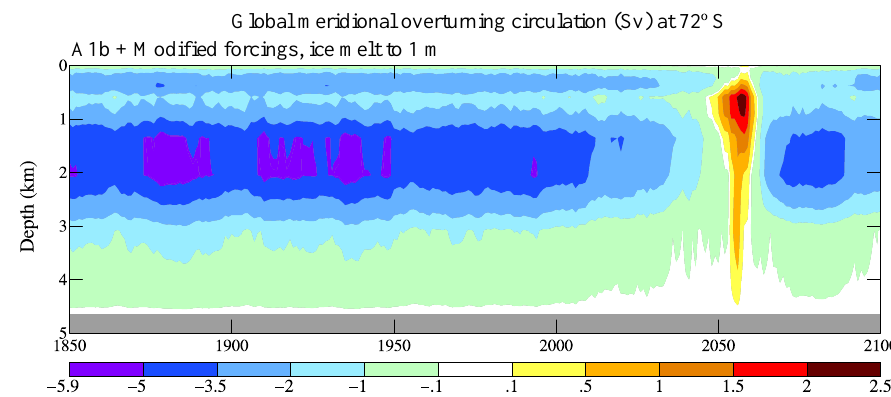
Figure 17. SMOC, ocean overturning strength (Sv) at 72 ◦ S, including only the mean (Eulerian) transport. This is the average of a five- member model ensemble for the modified forcing including advanced ice melt (720Gtyear − 1 from Antarctica in 2011) and 10-year doubling.